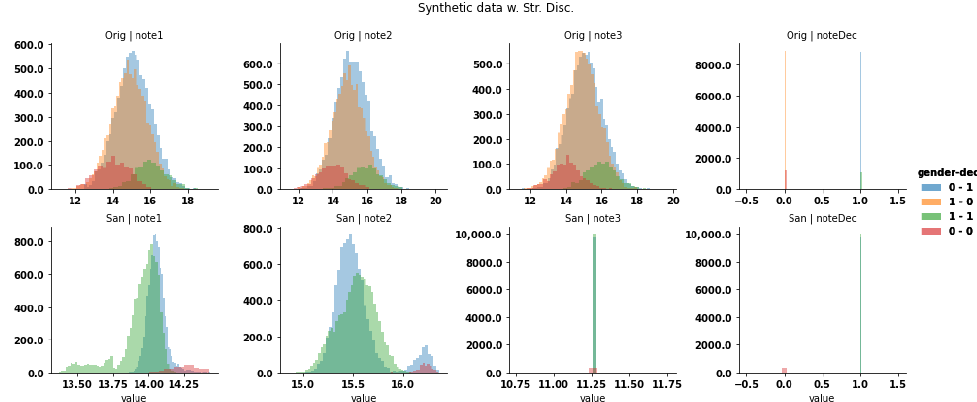
Figure 17. Distribution of attributes on a synthetic dataset with increase protection of the sensitive attribute (from a BER of 0.1 to almost